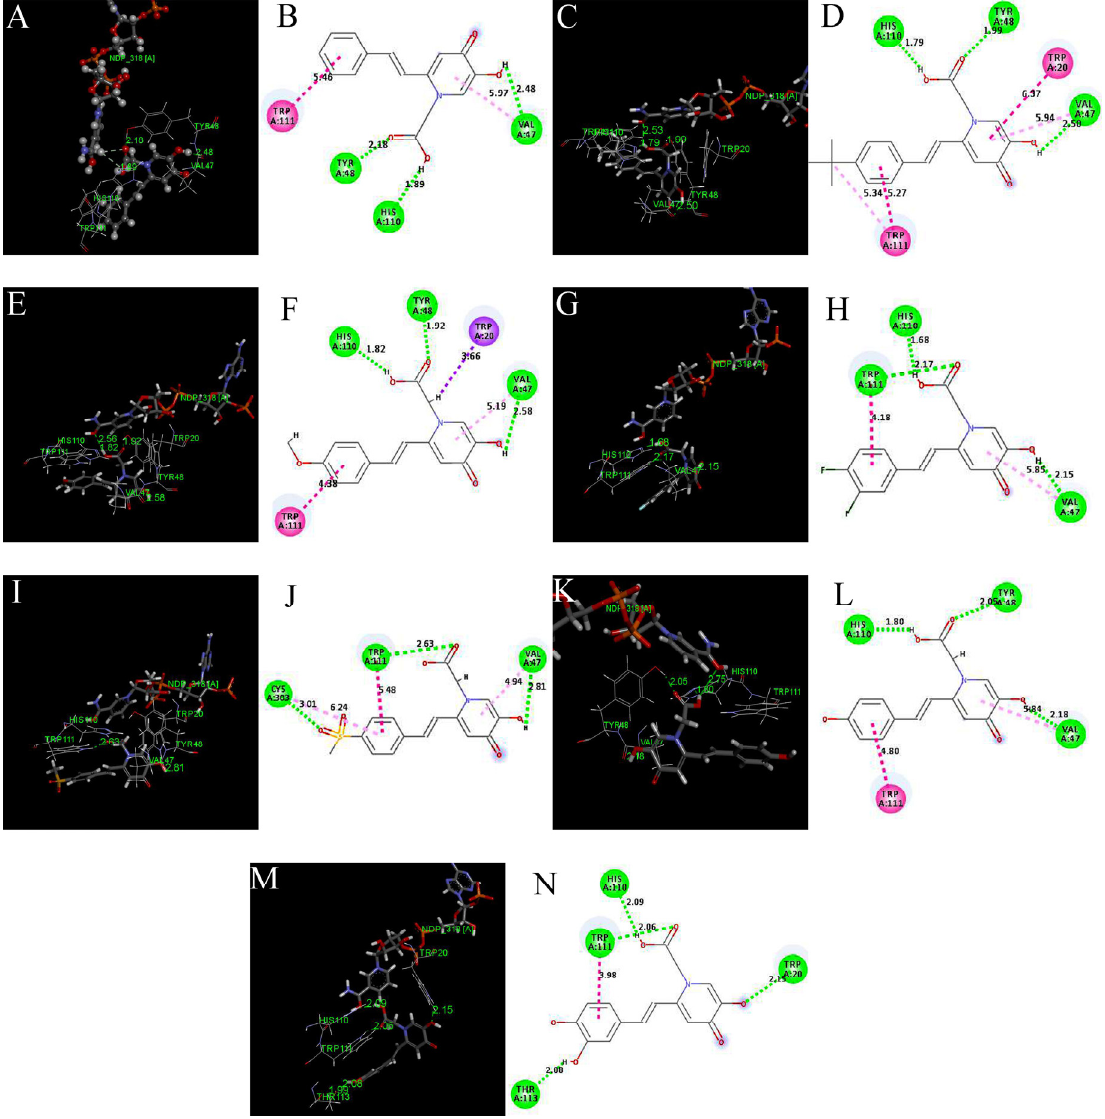
Figure 2. 3D docking results and 2D visualization of 5-hydroxy-4-oxo-2-styryl-4H-pyridine derivatives 7a ( A and B ), 7c ( C and D ), 7d ( E and F ), 7g ( G and H ), 7i ( I and J ), 7k ( K and L ) and 7l ( M and N ), respectively. In 3D docking results, the docked poses of the compounds are shown in gray ( C ), red ( O ), white ( H ) and blue ( N ), and hydrogen bonds are shown as yellow dashed lines, and lengths ( Å ) of the hydrogen bonds are labeled beside the dashed lines. In 2D representation, hydrogen bonds are shown as green dashed lines, and pi-pi stacking as pink dashed lines.